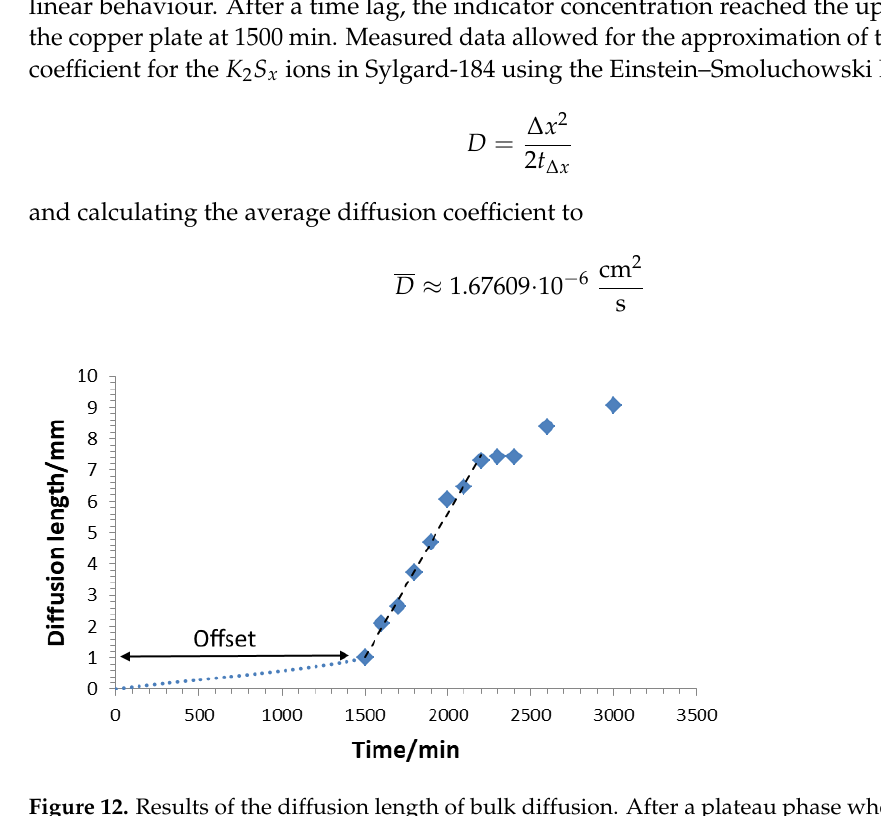
Figure 12. Results of the diffusion length of bulk diffusion. After a plateau phase where no colour change is visible on the indicator plate, the effect of bulk diffusion becomes visible. The offset is the time the corroding solution needs to diffuse through the bulk of the PDMS to reach the copper plate. During the time interval from 1500 min up to 2300 min, the corrosion of the copper migrates linearly along the tilted plate. Towards the end a saturation phase was observed as the gradient of concen- tration decreases.